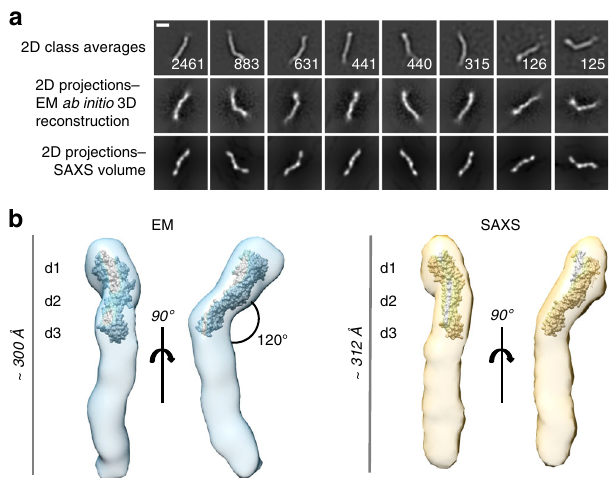
Fig. 4 The CD22 ectodomain adopts a tilted rod-like structure with low fl exibility. a The eight primary 2D class average images of CD22 ECD obtained by negative-stain EM ( top ). The number of particle images in each class is indicated. 2D projections of the ab initio EM reconstruction ( middle ) and the SAXS 3D volume ( bottom ) account for nearly all particles classi fi ed in 2D classes. Scale bar represents 10 nm. b Views of the ab initio EM reconstruction ( blue ) and SAXS volume ( yellow ). The crystal structure of CD22 20 – 330,5A is shown as a surface fi tted into the EM map and SAXS volume rendered with UCSF Chimera